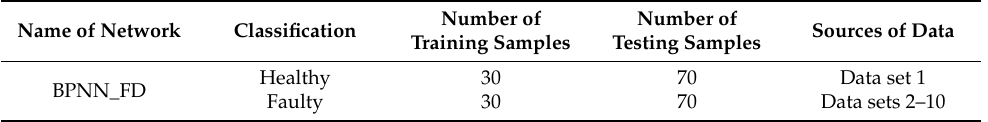
Table 2. Sample settings for the fault detection layer.